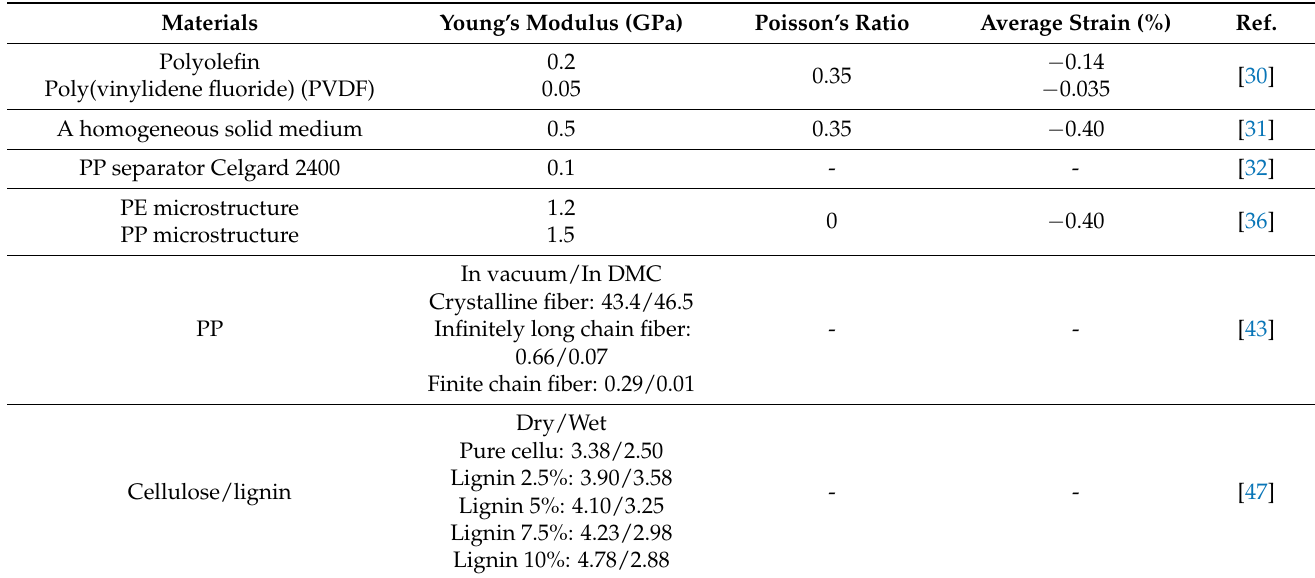
Table 3. Stress analysis summary for separators used in Li-ion